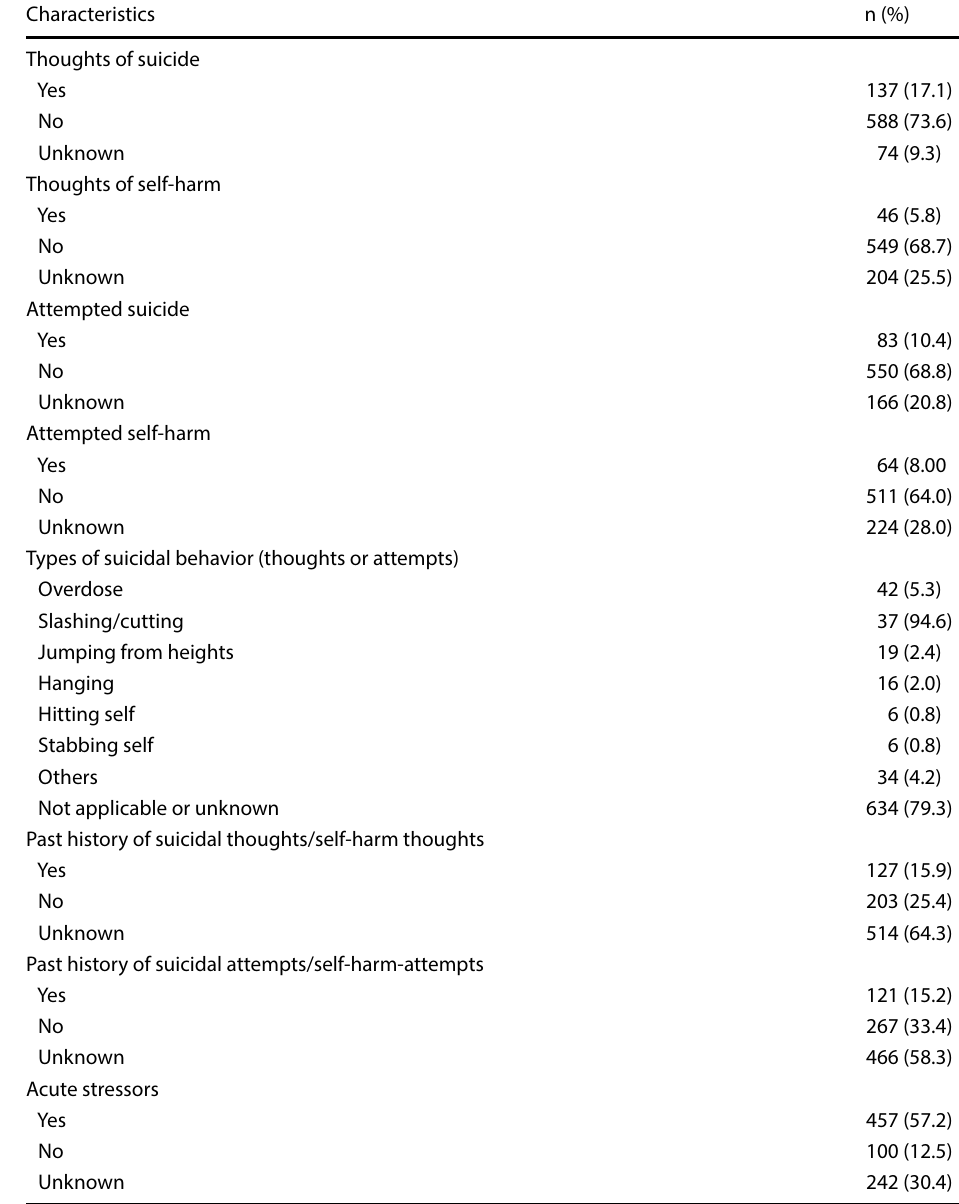
Table 3 Suicidal behavior- related characteristics of the sample (N = 799)